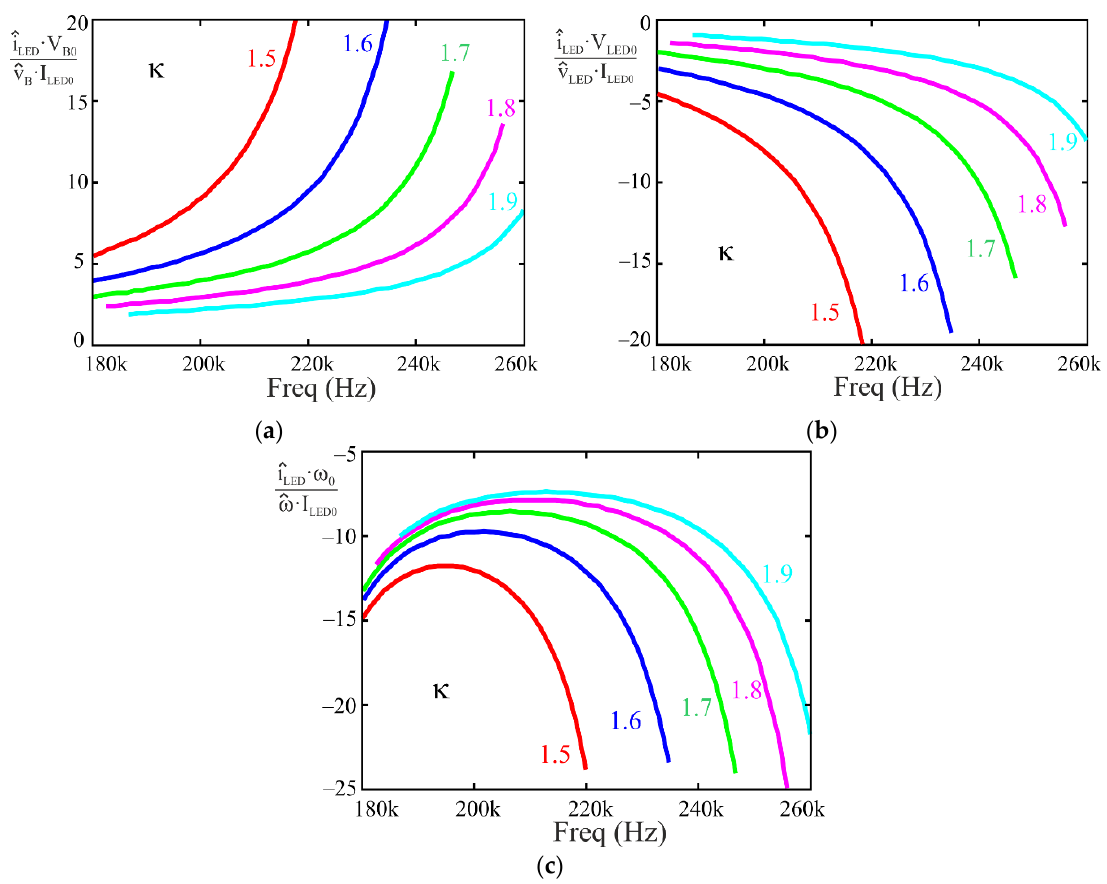
Figure 7. Sensitivity of LED current against changes in three different parameters as a function of the operating frequency: ( a ) Bus voltage; ( b ) LED voltage; ( c ) Frequency.